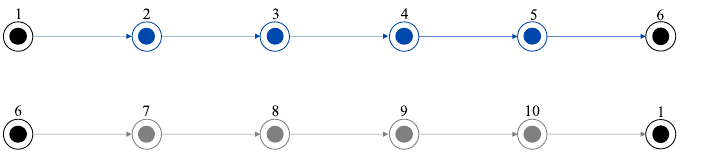
Figure 3. Bus stops scheme for line 14. Initial and final stops (black points) for outward (top) and return (bottom) journeys; intermediate stops for outward journey (blue); intermediate stops for return journey (grey).